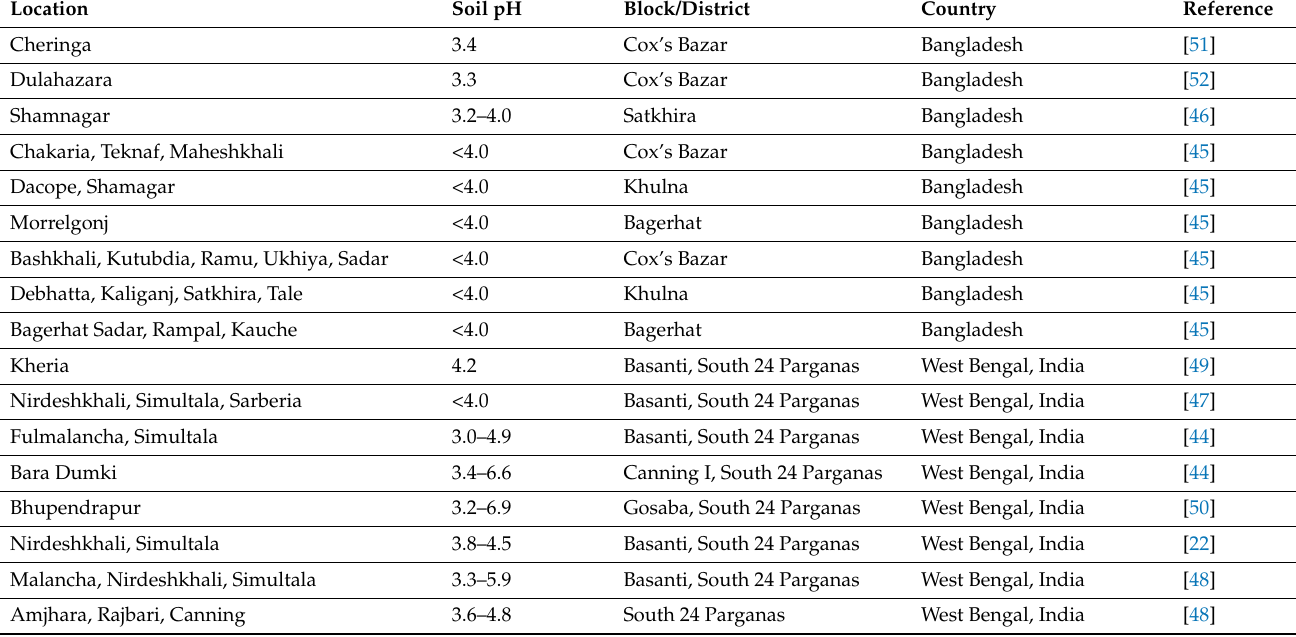
Table 1. Distribution and degree of soil acidity of acid sulphate soils in the Ganges